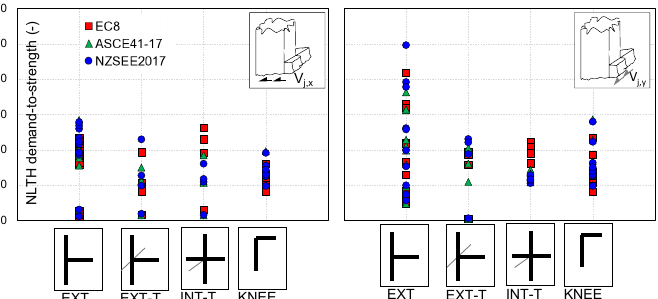
Figure 18. NLTH Demand-to-strength ratios for the beam–column joints of SPEAR frame. The reader is referred to the color version of this figure. (Note. NLTH demands are evaluated using extreme absolute values.) Table 4. Shear strength and demand evaluated for beam–column joints of the SPEAR frame. Shear Strength Shear Demand min(v j , x ) min(v j , y ) max(v j , x ) max(v j , y ) All the Values Are Expressed in MPa